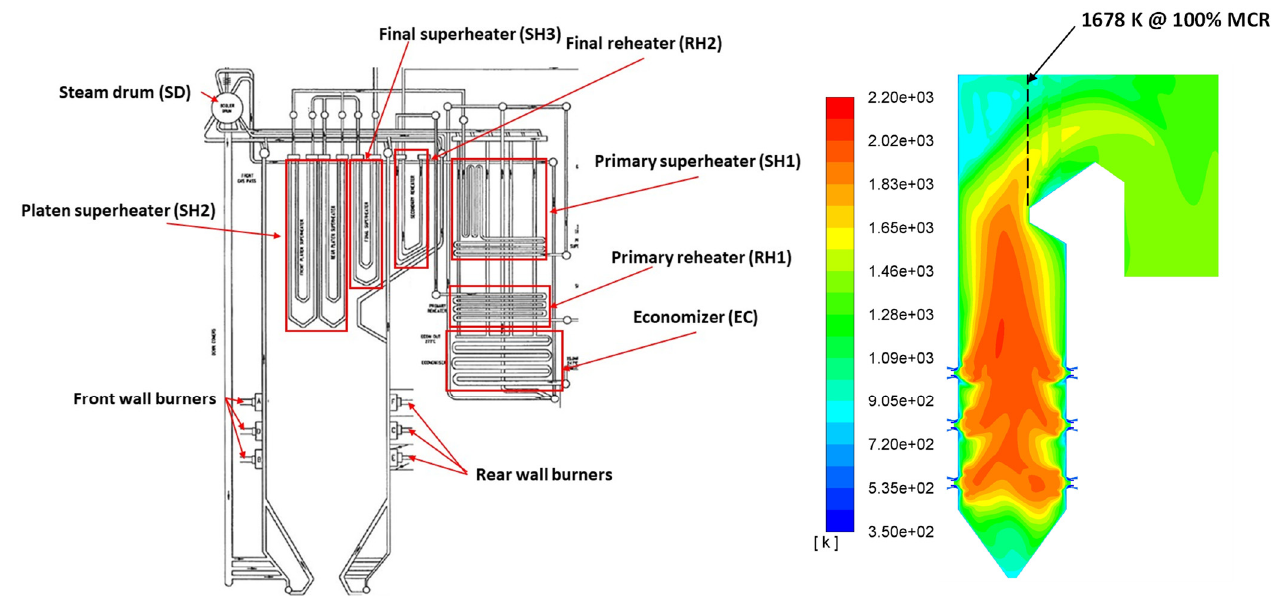
Figure 5. Utility-scale coal-fired boiler general arrangement ( left ) [2]; contour of gas temperatures for 100% case, calculated using CFD ( right ).